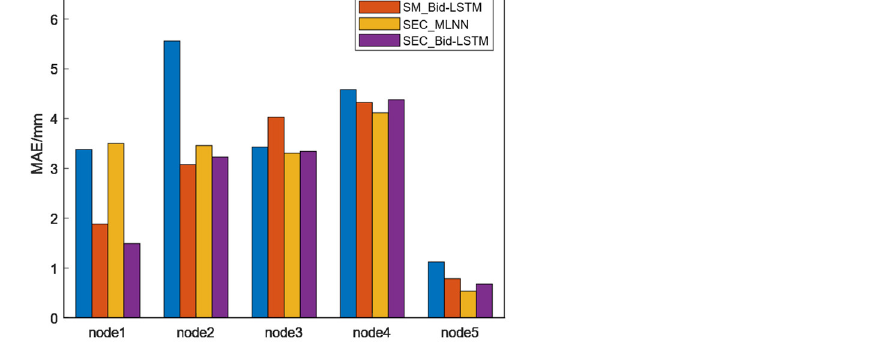
Figure 10. MAE performance comparison results between LSTM and MLNN for the prediction of SM and SEC.